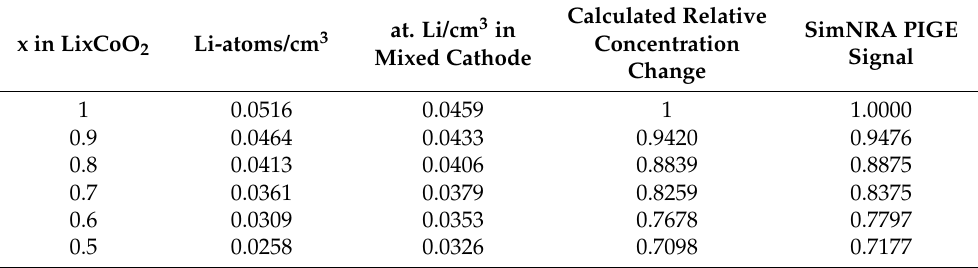
Table A2. Calculated at Li/cm 3 for various SoC in the LCO + LLZO mixed cathode and simulated PIGE signal by SIMNRA enabling a reverse calculation of x from the measured PIGE signal.